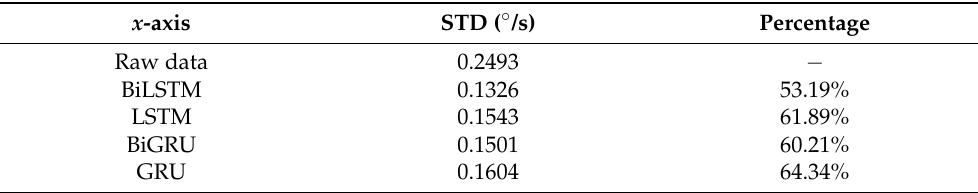
Table 7. Comparison of raw data, BiLSTM, LSTM, BiGRU, and GRU standard deviation values for z -axis data.